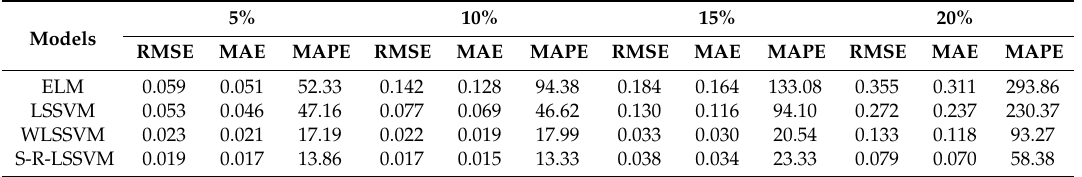
Table 2. Comparison of the test results for the nonlinear differential